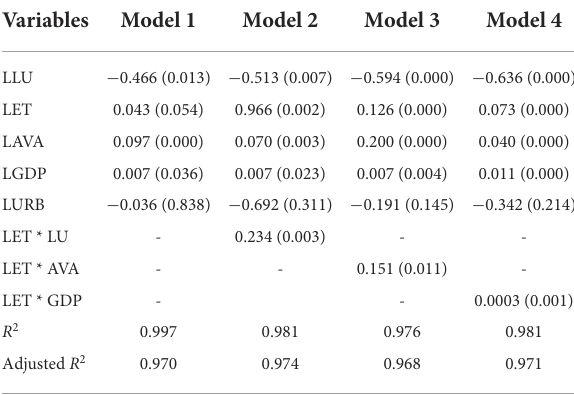
TABLE 5 Pedroni and Kao estimators. TABLE 6 FMOLS